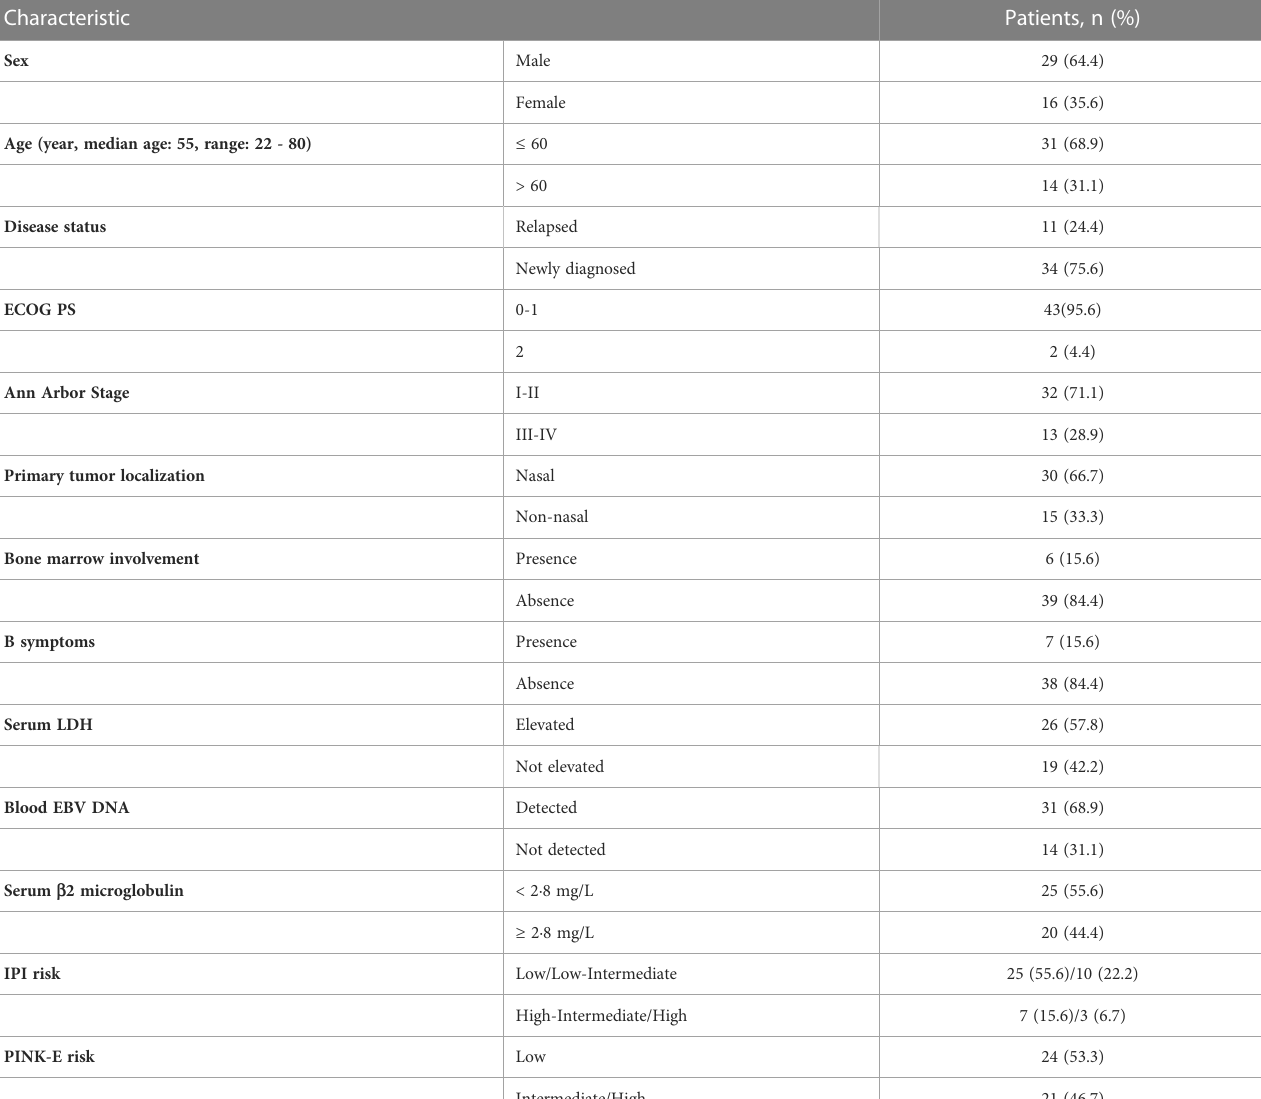
TABLE 1 Characteristics of 45 ENKTL patients in the study.